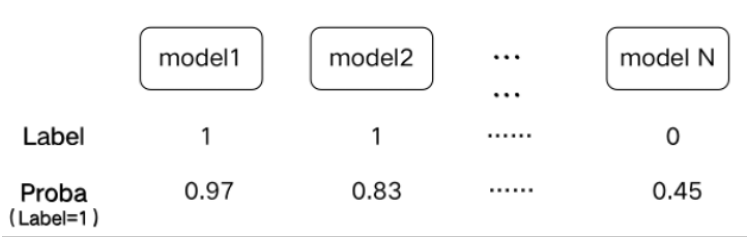
Figure 3. Label-Proba matrix of a sample. 2.